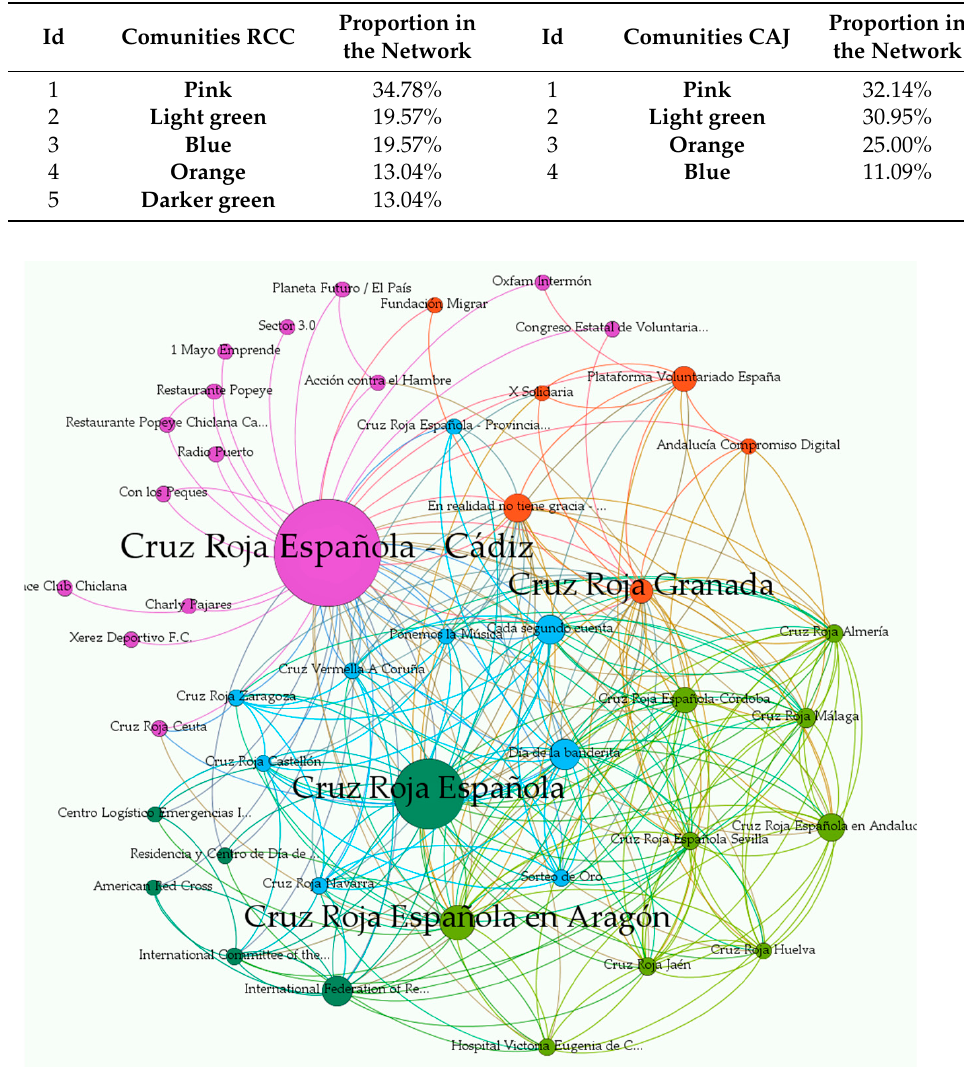
Figure 1. Display of the Red Cross Cadiz’s interest groups on Facebook.